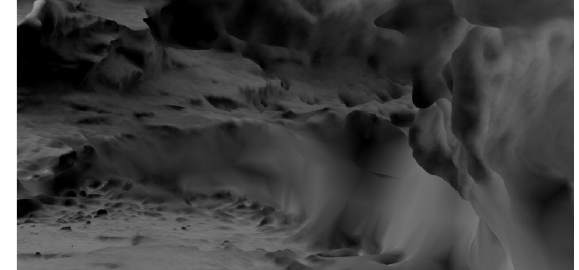
Figure 6. A sample of PCV Ambient Occlusion filter.